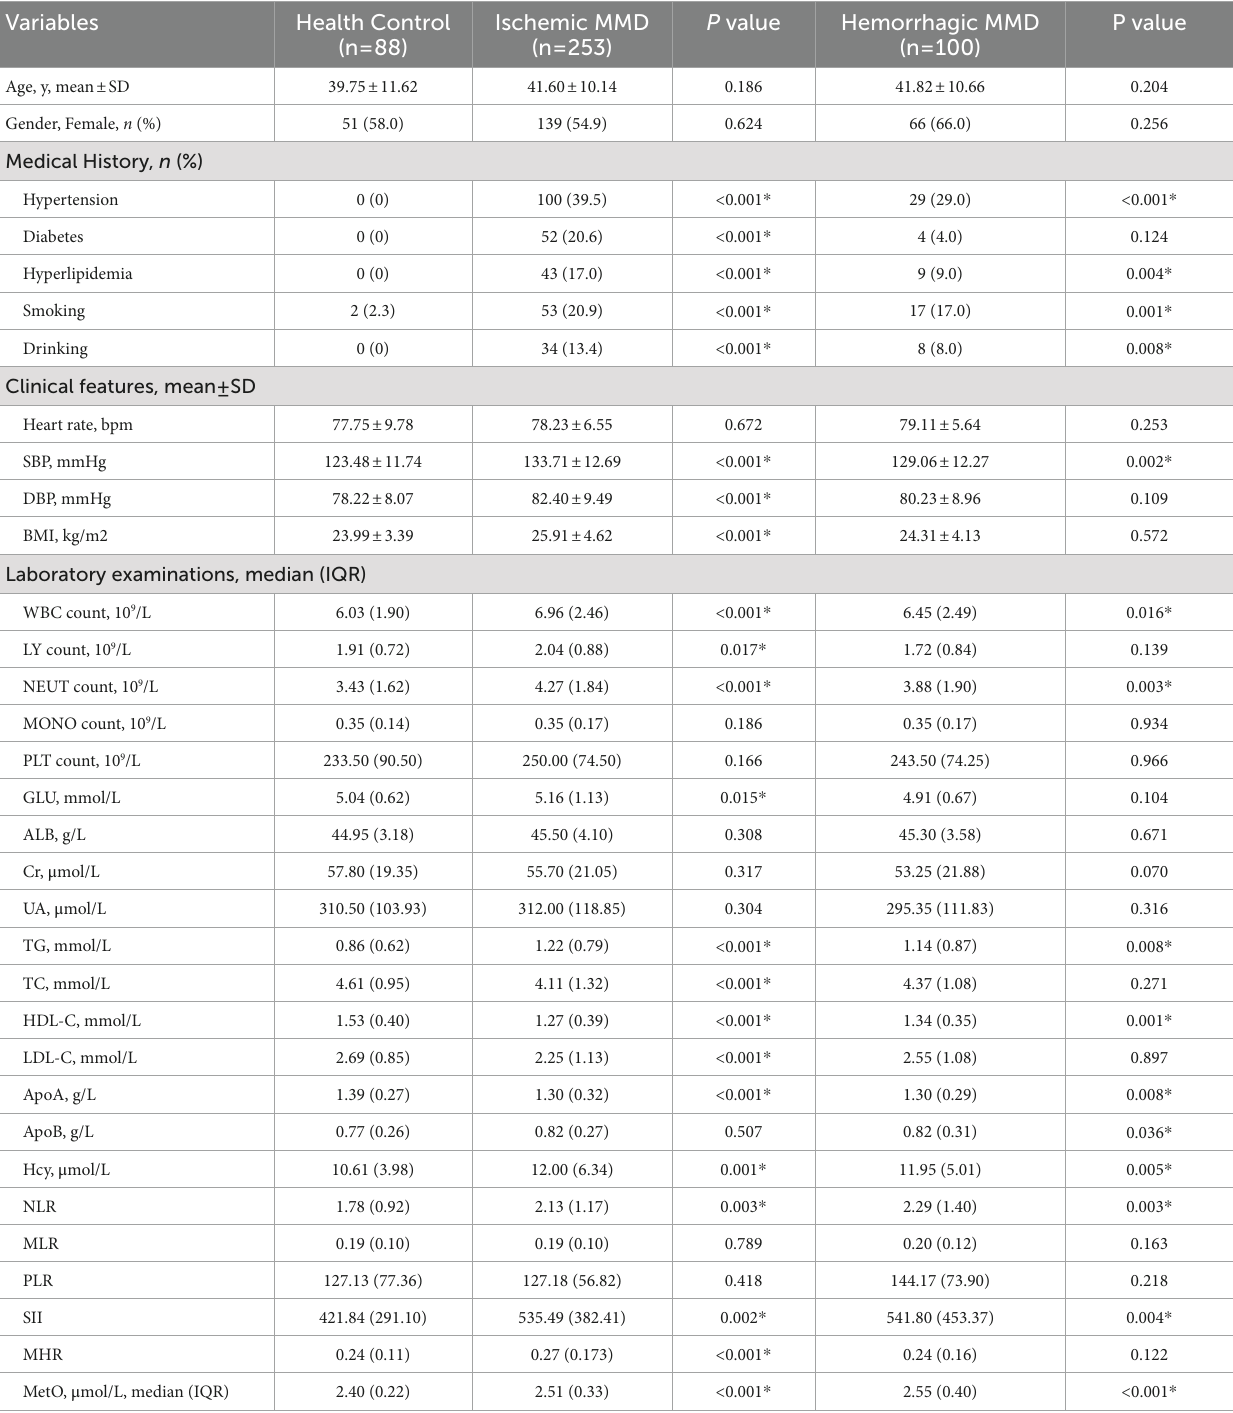
TABLE 2 Baseline characteristics between HCs and MMD